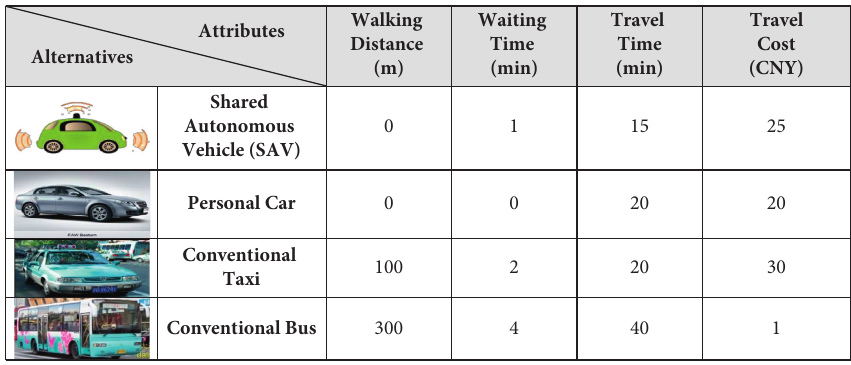
Figure 3: Example of a choice experiment in